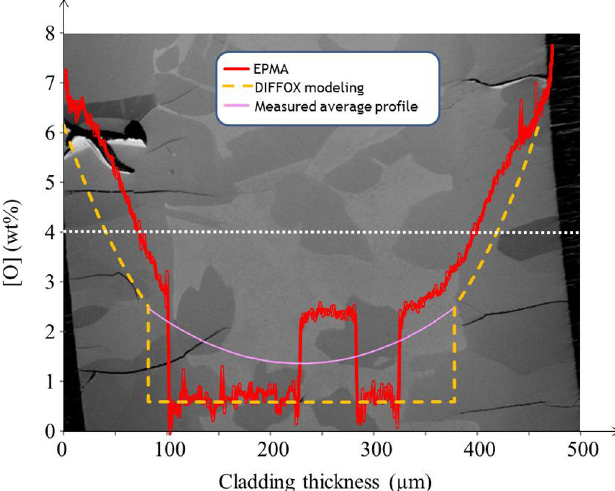
Fig. 6. EPMA oxygen pro fi les versus DIFFOX calculation or measured average pro fi le (H64-3).